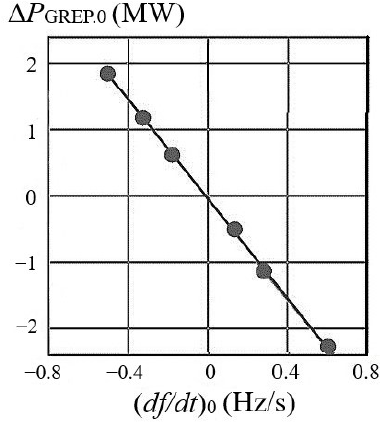
Figure 3. Graph of the relationship ∆ P GREP . 0 = φ ( df / dt ) in the power supply system with GREPs ( K df ≈ − 3.74 MW ∙ s/Hz).